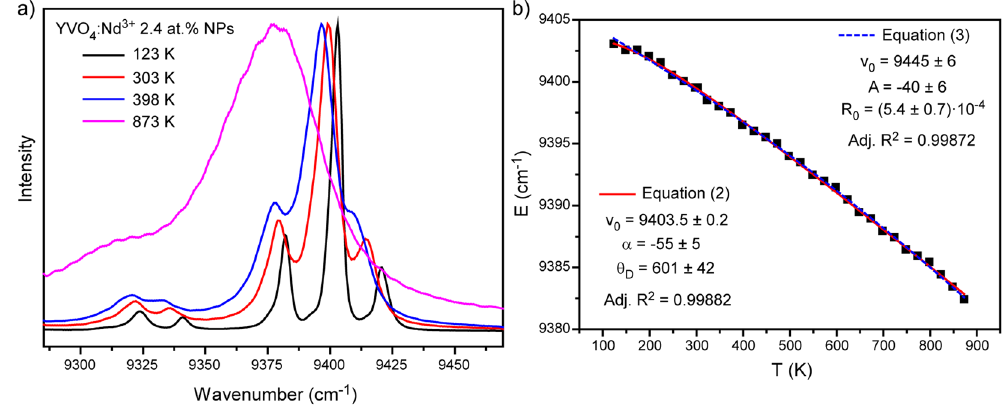
Figure 2. ( a ) Normalized emission spectra of 4 F 3/2 − 4 I 11/2 transition obtained at different temperatures